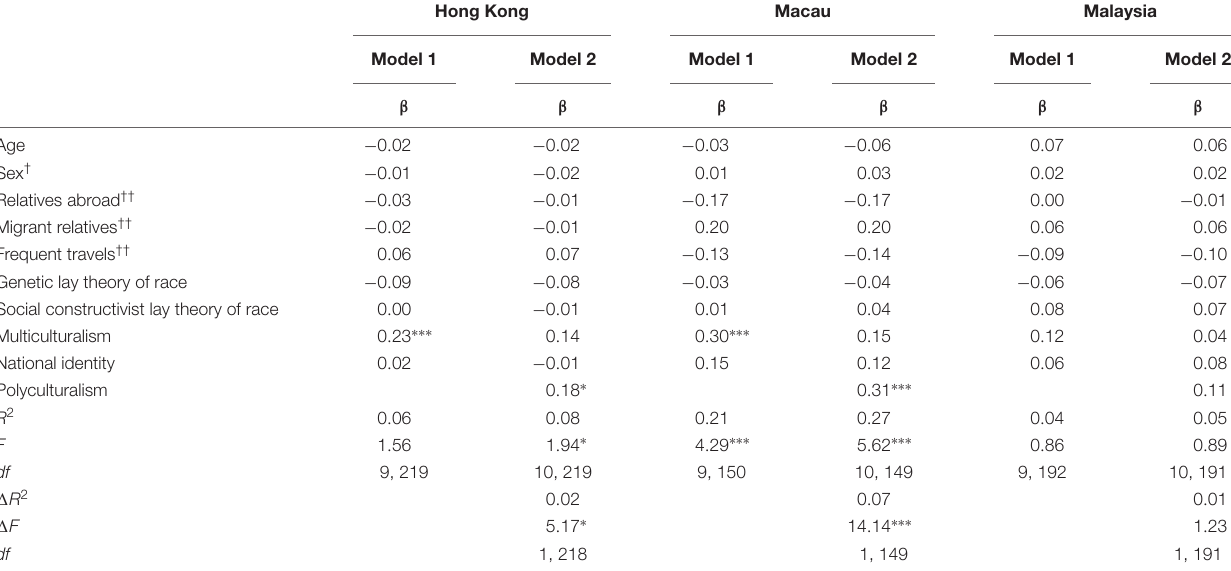
TABLE 3 | Summary of regression analysis predictors of attitudes toward continuing colonial presence in three Asian